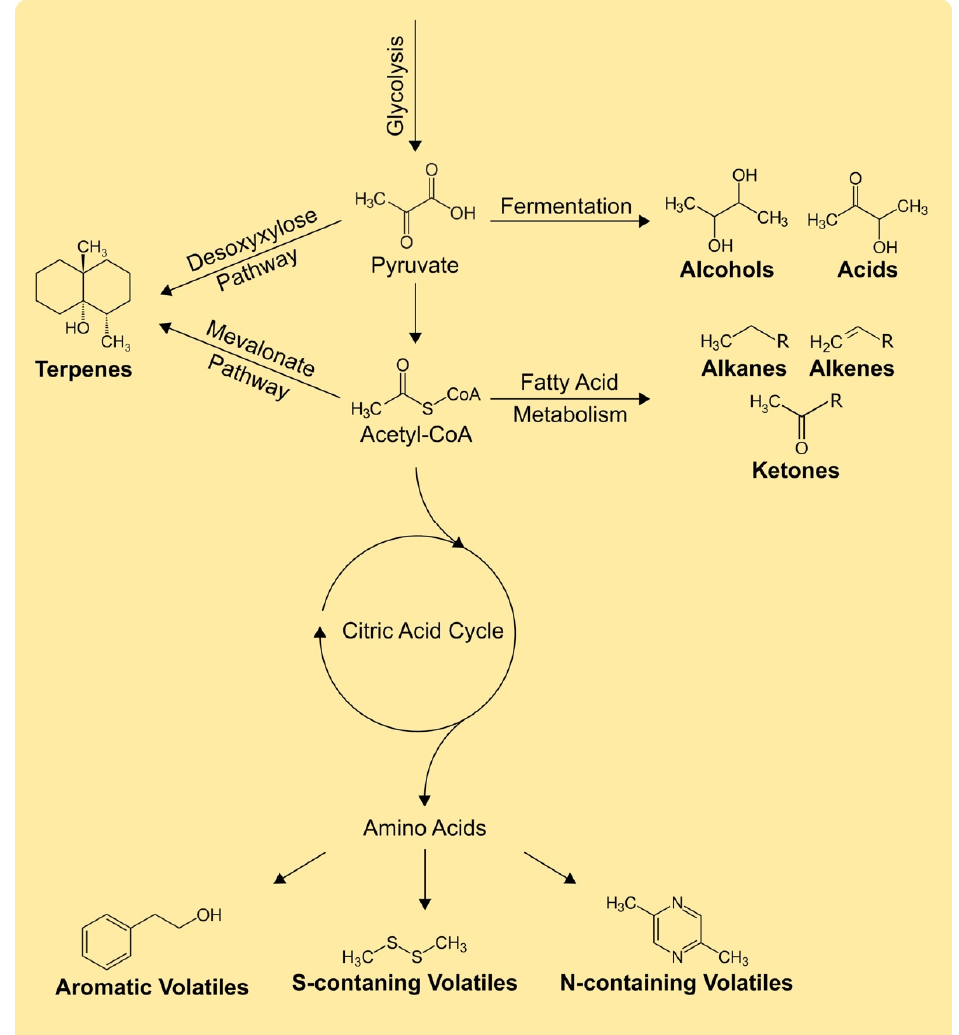
Figure 1. Overview of main biochemical pathways for the production of bacterial volatiles. The chemical structures show representative examples: alcohols (2,3-butanediol), acids (acetoin), alkanes (general structure), alkenes (general structure), ketones (general structure), terpenes (geosmin), aromatic volatiles (2-phenylethanol), S-containing volatiles (dimethyl disulfide) and N-containing volatiles (2,5-dimethylpyrazine). Details are described in the main text. Under aerobic conditions pyruvate will be metabolized to acetyl-CoA and can enter the fatty acid anabolism, citric acid cycle or be converted to terpenes. The fatty acid me- tabolism results mainly in alkanes, alkenes, aliphatic alcohols and ketones. The β-oxida- tion with acetyl-CoA results only in fatty acids with even numbers, for odd-chain fatty acids propionyl-CoA replaces one acetyl-CoA in the final step [33]. Typical volatile prod- ucts from the fatty acid pathway are aldehydes such as nonanal, ketones such as nonan- 2-one or fatty acids such as nonanoic acid [26].